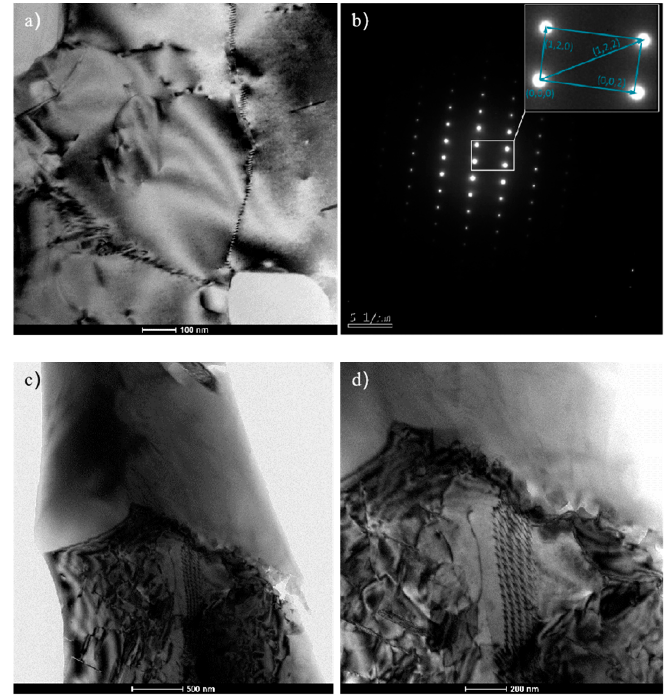
Figure 12. Recovery and whisker fracture of the extruded aluminum matrix composites: (a)The sub- grain boundary; (b)Al 18 B 4 O 33 w diffraction spots; ( c ) The whisker fracture; ( d ) The interface at the fracture of the whisker.